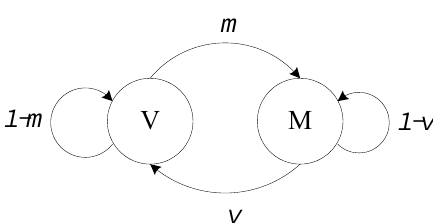
Figure 4. State transition of child